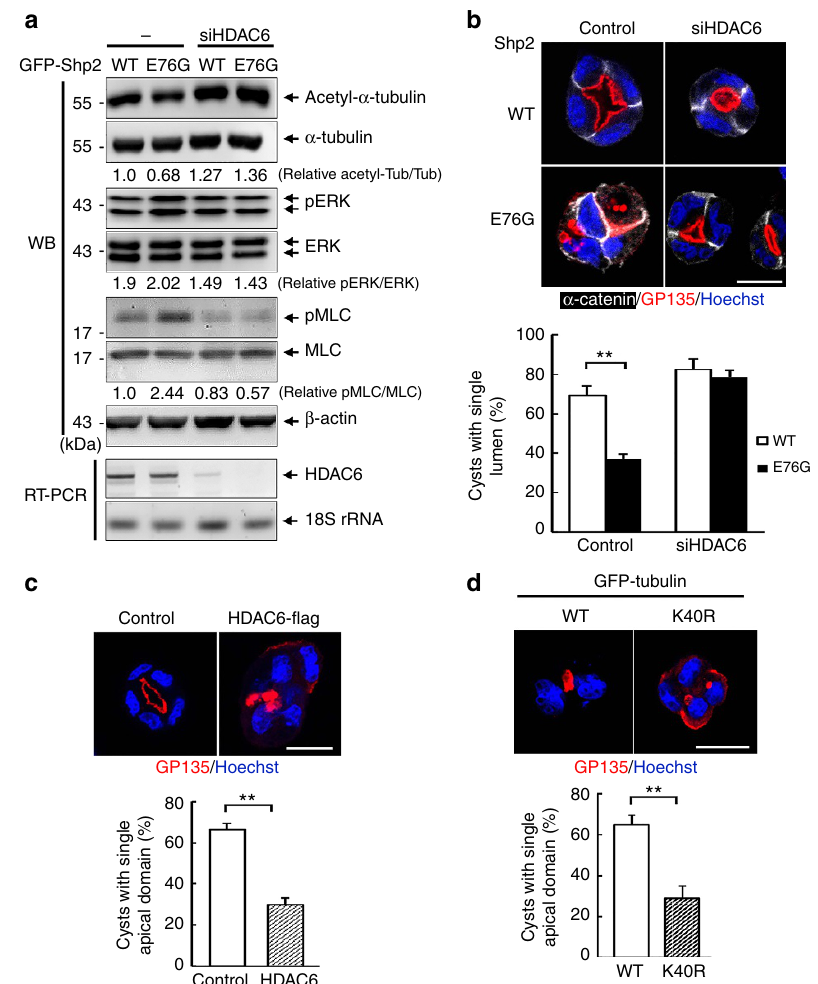
Figure 4 | Role of HDAC6 in lumen formation and Microtubule acetylation in normal lumenogenesis. MDCK cells expressing GFP-Shp2-WT and GFP-Shp2-E76G were transfected with HDAC6 siRNA. ( a ) Western blot analysis. RT-PCR shows the knockdown effect.( b ) Cells grown in Matrigel for 2 days were fixed for immunostained with antibodies as indicated. The percentage of cysts with single apical domain is shown in the right (516–641 cysts were counted in each experiment, n ¼ 3). ( c ) Control MDCK cells were co-transfected with control vector or HDAC6-Flag with GFP-C1 (amount of DNA ratio at 3:1). These cells were embedded into Matrigel for 2 days. Cysts were fixed for IF staining as indicated. The percentage of GFP positive cysts with single apical domain is shown at the bottom (167–193 green cysts were counted in each experiment, n ¼ 3). ( d ) Control MDCK cells were transfected with GFP-Tubulin WTor K40R mutant and embedded in Matrigel for 2 days. Cysts were fixed for IF staining with anti-GP135 (red) and Hoechst (blue), scale bar, 10 m m. The percentage of cysts with single apical domain is shown below (104–121 green-positive cysts were counted in each experiment, n ¼ 3). Values are mean ± s.d. from three independent experiments. ** P o 0.01 based on two-tailed unpaired Student’s t